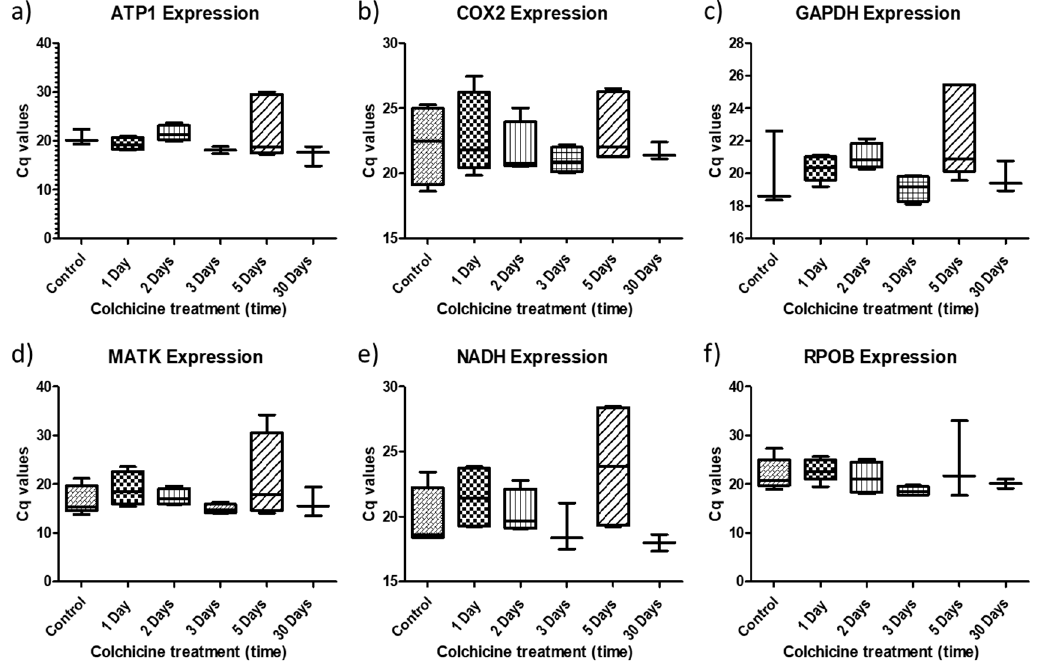
Figure 5. Graphs of absolute expression of ATP1, COX2, GAPDH, MATK, NADH and RPOB genes in blueberry plants subjected to different treatments with colchicine (1 day, 2 days, 3 days, 5 days and 30 days): (a) ATP1 ; (b) COX2 ; (c) GAPDH ; (d) MATK ; (e) NADH ; (f) RPOB .